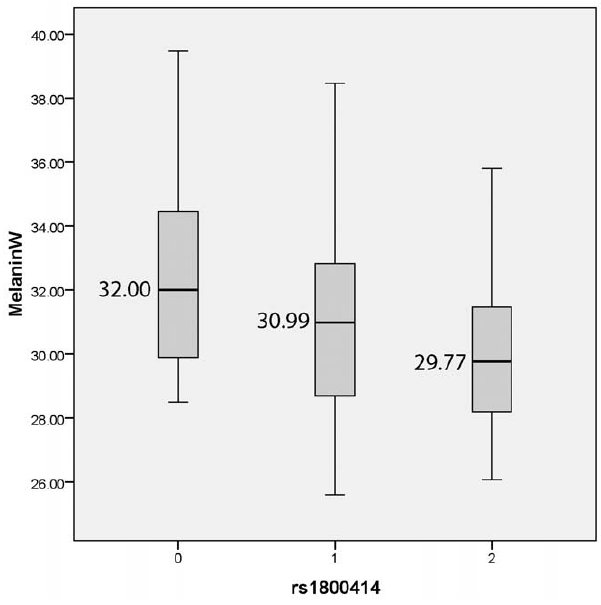
Figure 1. Boxplot showing melanin index by rs1800414 genotype for the Canadian East Asian sample. The top of the box is the 75 th percentile, the bottom of the box is the 25 th percentile and the line in the centre is the median. The lines extending from the box mark the highest and lowest melanin index measurements.